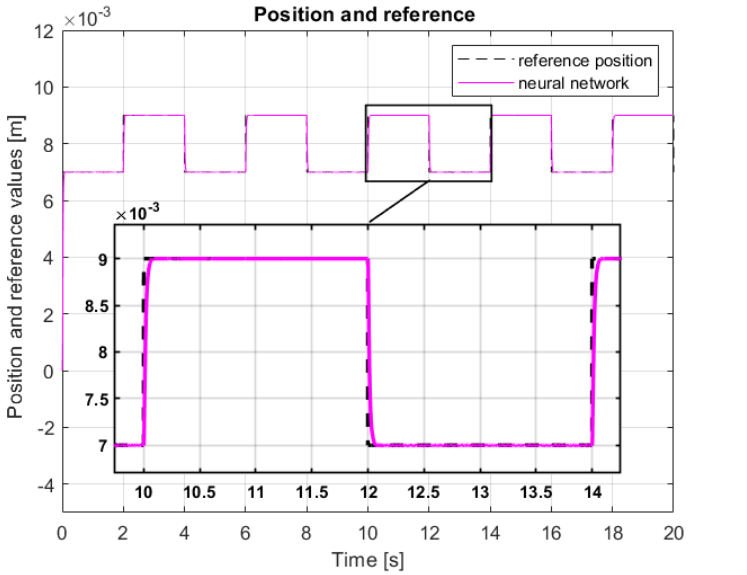
Figure 12. The system response—the neural network controller case.